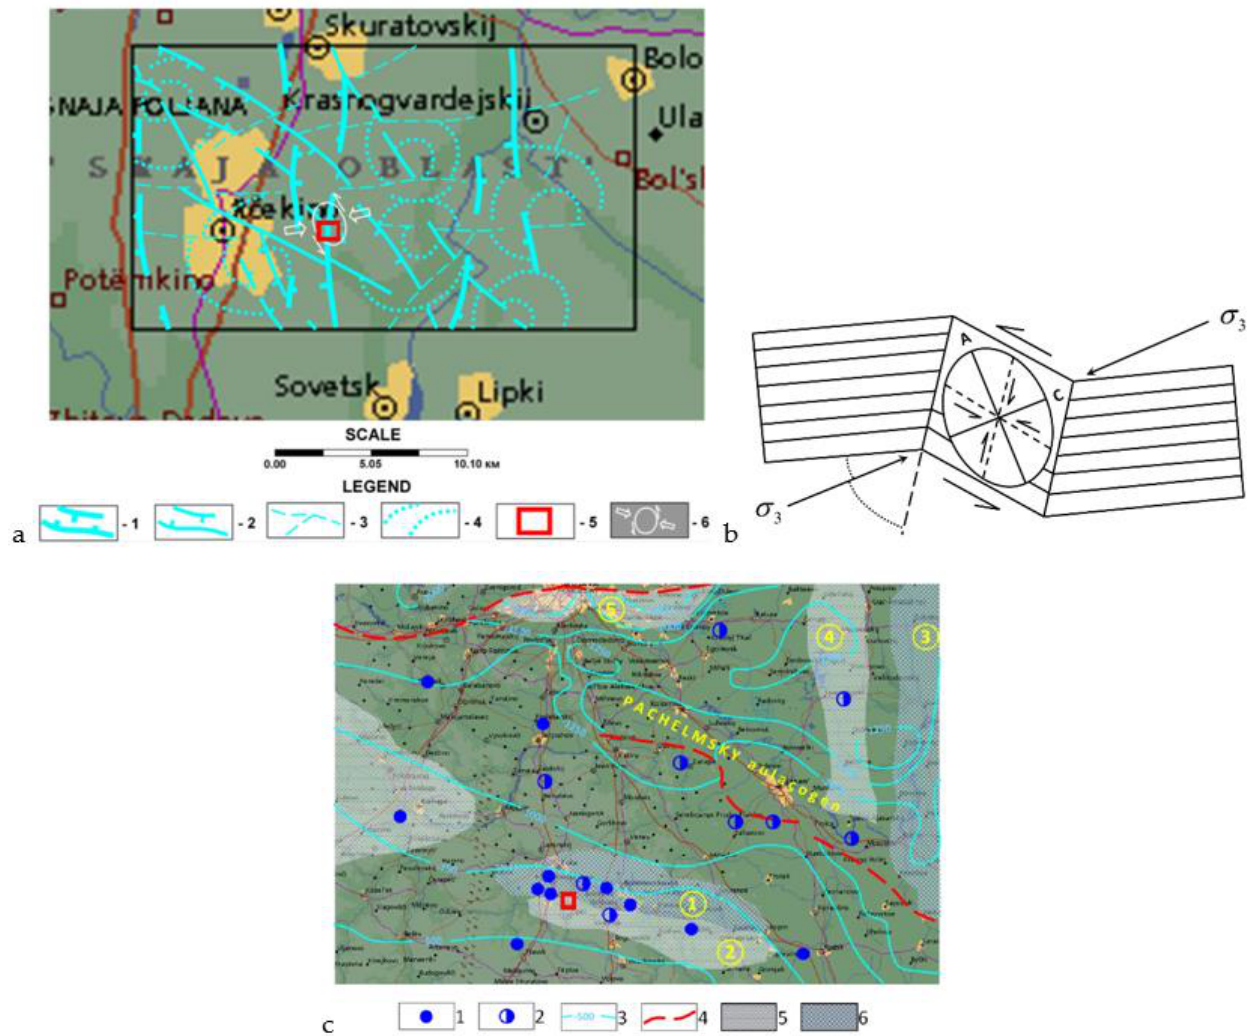
Figure 3. The elements of regional geostructural reconstruction: ( а ) tracing the planetary fractures within the central part of the Tula region (1 – 4 — different ranked elements of fault tectonics with ranking according to the degree of particular fracture fragmentation; 5 — arch elements organized into ring structures; 6 — position of investigated area; white lines reflect the reconstruction of normal stresses according to the model of deformation ellipsoid in the vicinity of investigated area marked by blue contour); ( b ) the model of deformation ellipsoid [39] with orientation of long axis of ellipsoid along bisector of acute angle between conjugated cracks (approximately under 60 degrees to each other) with shear kinematics; 3 s is the normal stresses; ( c ) fragment of tectonic map of the Russian Platform (according to K.Yu. Volkov [40]) (1 — the wells uncovering the crystalline basement (numerator is the marker of depth of the roof, denominator includes total depth of drilling; 2 — the wells where total depth of drilling is smaller than depth of crystalline basement roof; 3 — isohypse of roof of crystalline basement according to combination of drilling data and seismic prospecting; 4 —the same as “3” but according to the data of gravity survey; 5 — deep fault; 6 — local synforms; 7 — local antiforms. Numbers in circles: 4 — Trufano-Paveletskaya uplift zone; 5 — Shchekino-Gorlovskaya zone of troughs; 6 — Oksko-Tsinisky swell; 7 — Vladimir-Shilovsky trough; 8 — Moscow graben).